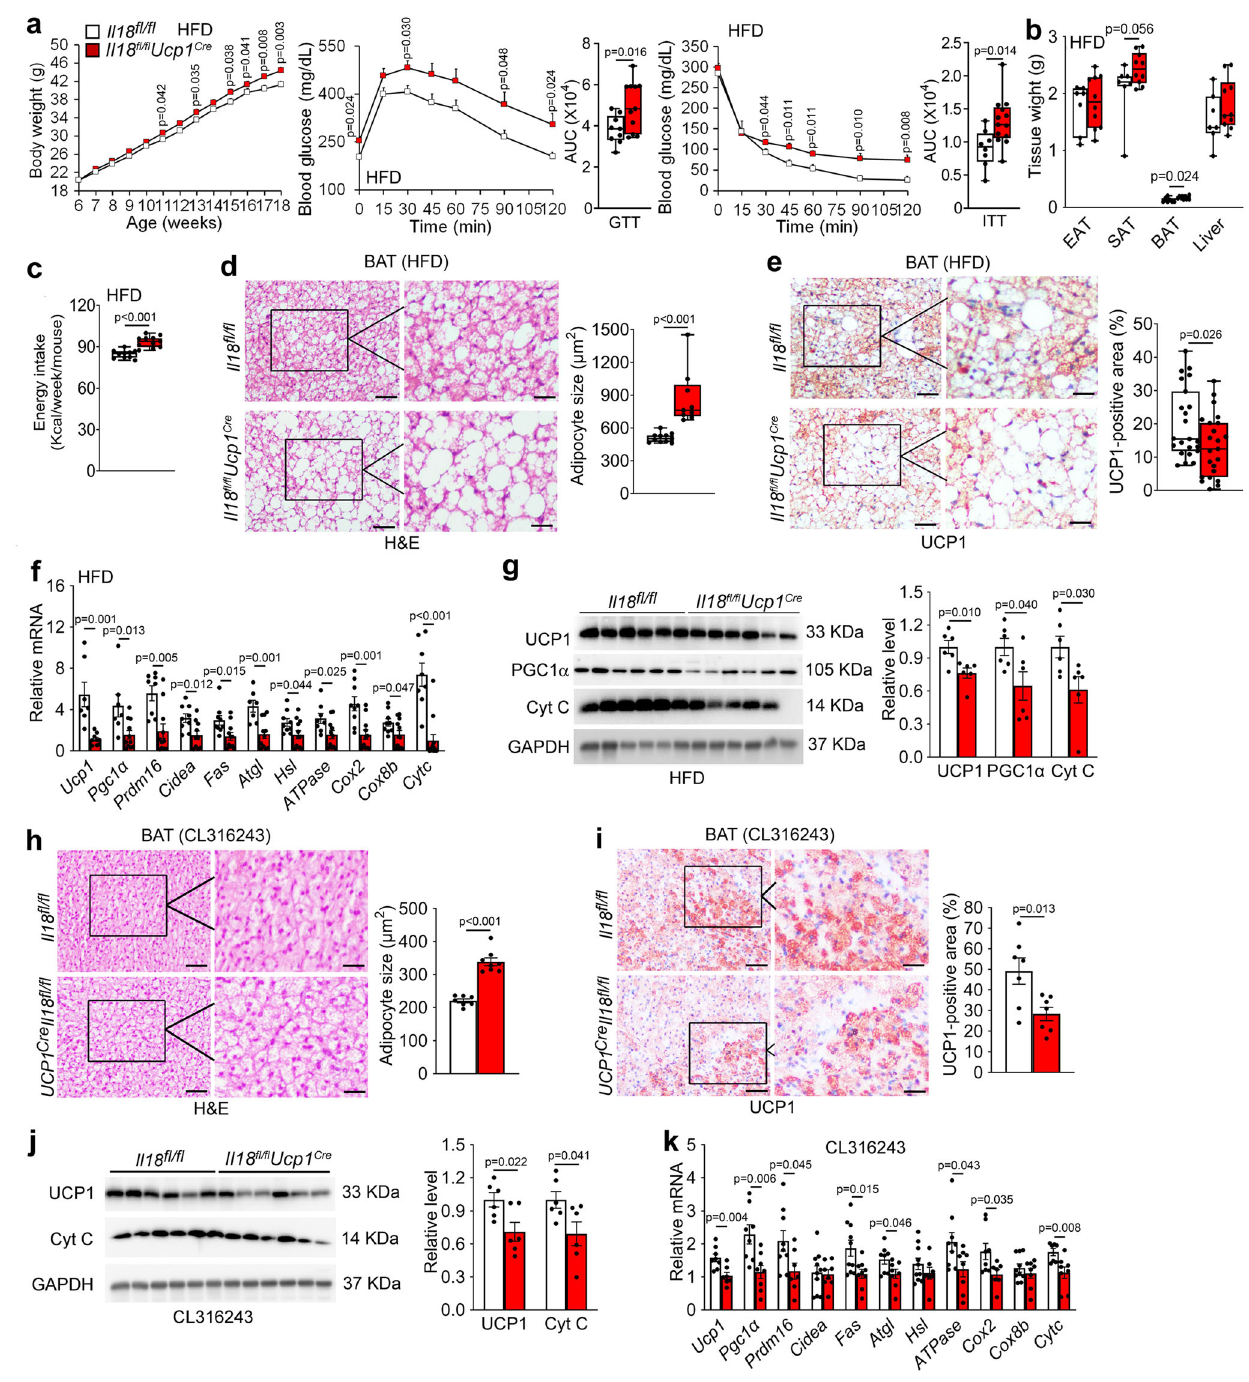
Fig. 6 | BAT-selective IL18 depletion in Il18 fl / fl Ucp1 Cre mice exacerbates obesity and insulin resistance and impairs BAT thermogenesis. a – c Bodyweight gain ( Il18 fl / fl : n =10; Il18 fl / fl Ucp1 Cre : n =13), GTTand AUC of GTT( Il18 fl / fl : n =9; Il18 fl / fl Ucp1 Cre : n =12),ITTandAUCofITT( Il18 fl / fl : n =8; Il18 fl / fl Ucp1 Cre : n =13)( a ),EAT,SAT,BAT,and liver weights( Il18 fl / fl : n =7; Il18 fl / fl Ucp1 Cre : n =10) ( b ),and energyintake ( Il18 fl / fl : n =10; Il18 fl / fl Ucp1 Cre : n =11) ( c ) in Il18 fl / fl and Il18 fl / fl Ucp1 Cre mice fed a HFD for 12 weeks. d – e H&E ( Il18 fl / fl : n =11; Il18 fl / fl Ucp1 Cre : n =9) ( d ) and UCP1 immunostaining ( Il18 fl / fl : n =23; Il18 fl / fl Ucp1 Cre : n =23)( e )ofBATfromindicatedgroupsofmice.Scale:50 μ m. Inset: 25 μ m. f RT-PCR analysis of thermogenic, lipolytic, and mitochondrial genes expression in BAT from indicated mice ( Il18 fl / fl : n =8; Il18 fl / fl Ucp1 Cre : n =11).